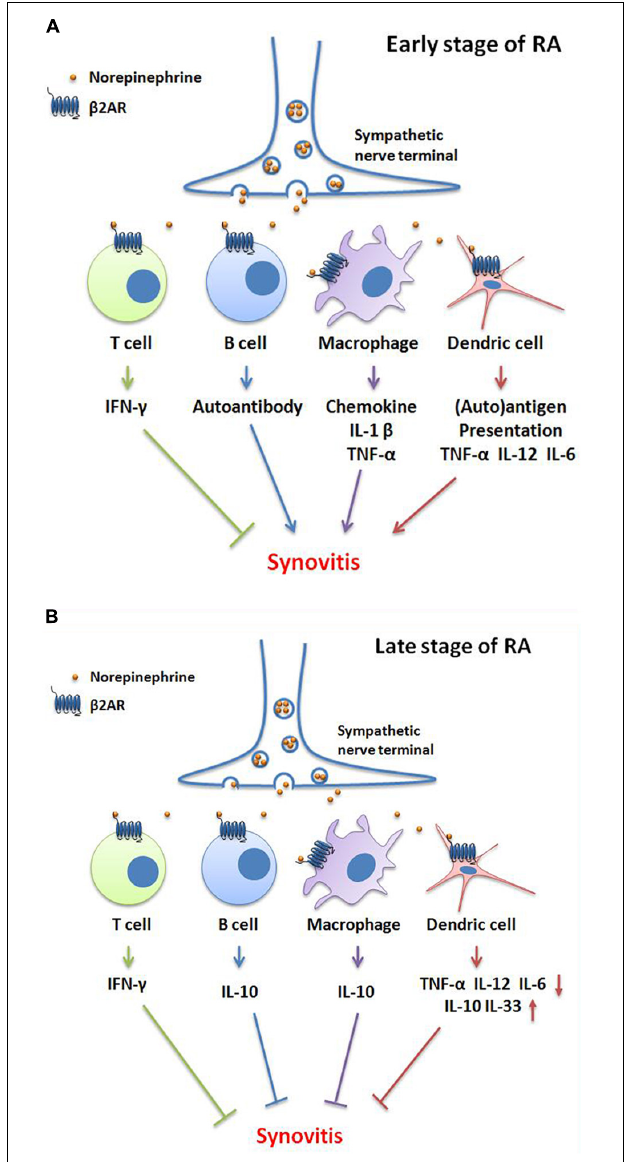
FIGURE 1 | Bidirectional functions of β 2-AR signaling in different stages of RA. (A) In the early stage of RA, norepinephrine-mediated- β 2-AR signaling promotes IFN- γ production of T cells, which is an inhibitory cytokine in RA. However, β 2-AR facilitates autoantibody secretion by B cells; chemokine, IL-1 β and TNF- α production by macrophages; and auto-antigen presentation, TNF- α , IL-12 and IL-6 generation by dendric cells (DCs), consequently aggravates synovitis and clinical symptoms. (B) In the late stage of RA, the activation of β 2-AR induces IFN- γ production by T cells; IL-10 generation by B cells and macrophages; decreases the secretion of TNF- α , IL-12, and IL-6 and, increases the IL-10 and IL-33 levels by DCs. These changes then attenuate synovitis and clinical